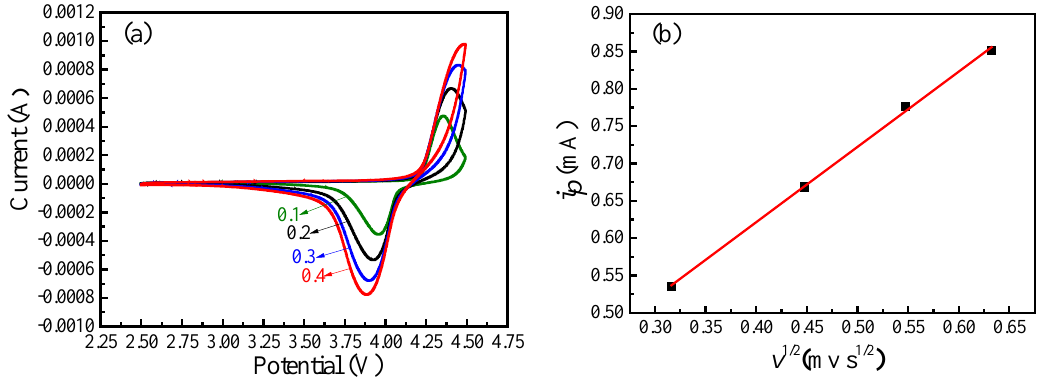
Figure 9. ( a ) Cycle voltammetry curve of the prepared LiMnPO 4 /C; and ( b ) the plots of peak current density ( i p ) as a function of the square root of the scan rate ( v 1/2 ).